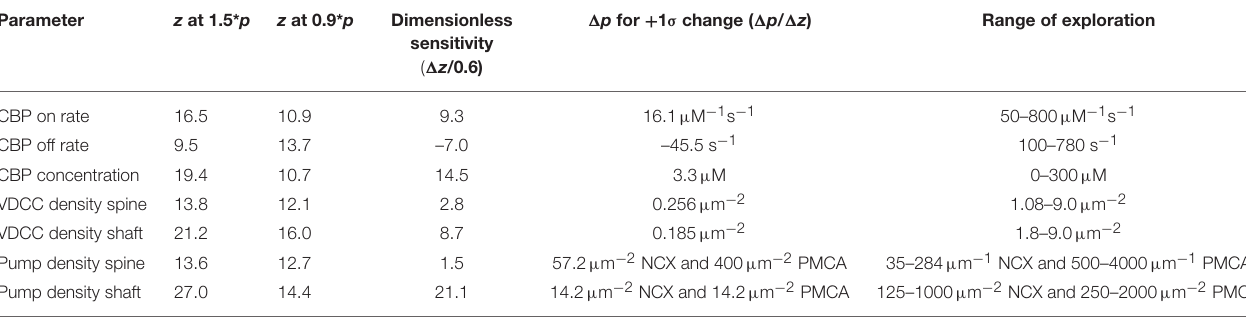
TABLE 2 | Parameter sensitivity in four dimensional measurement space.